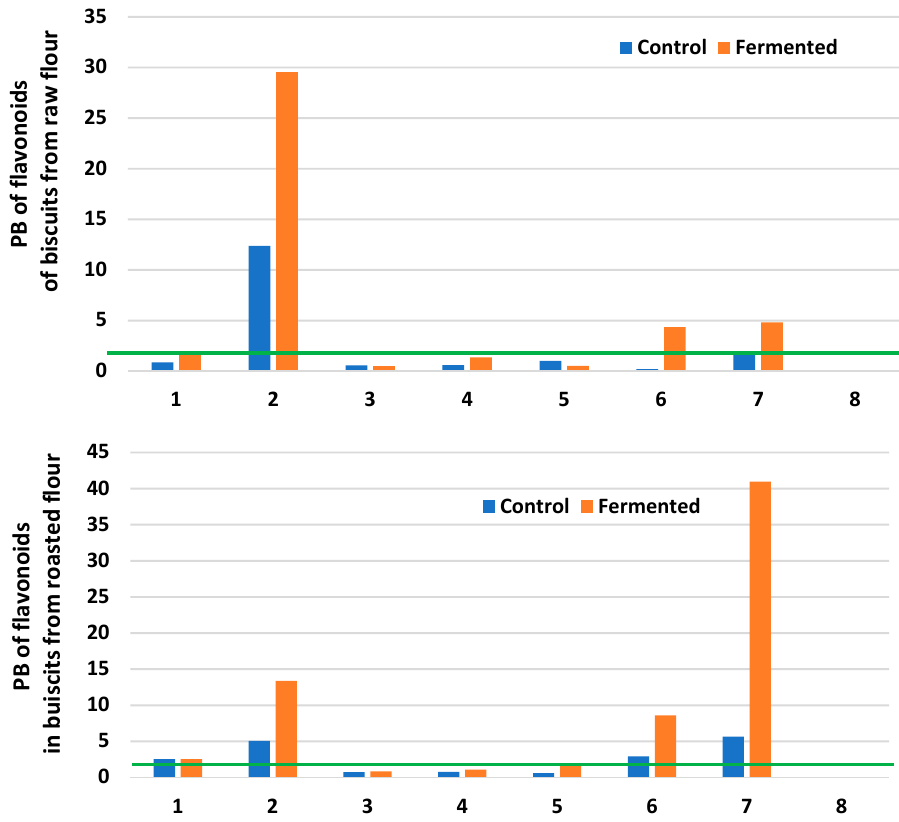
Figure 2. Potential bioaccessibility (PB) of flavonoids from biscuits obtained from raw and roasted buckwheat flour. PB > 1: high bioaccessibility; PB < 1: low bioaccessibility. Flavonoids: luteolin (1); kaempferol (2); vitexin (3); apigenin (4); orientin (5); epicatechin (6); quercitin (7); rutin (8).